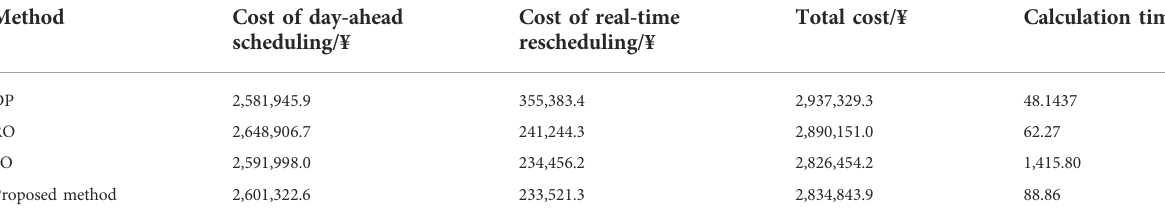
TABLE 6 Results comparison of different optimization methods.